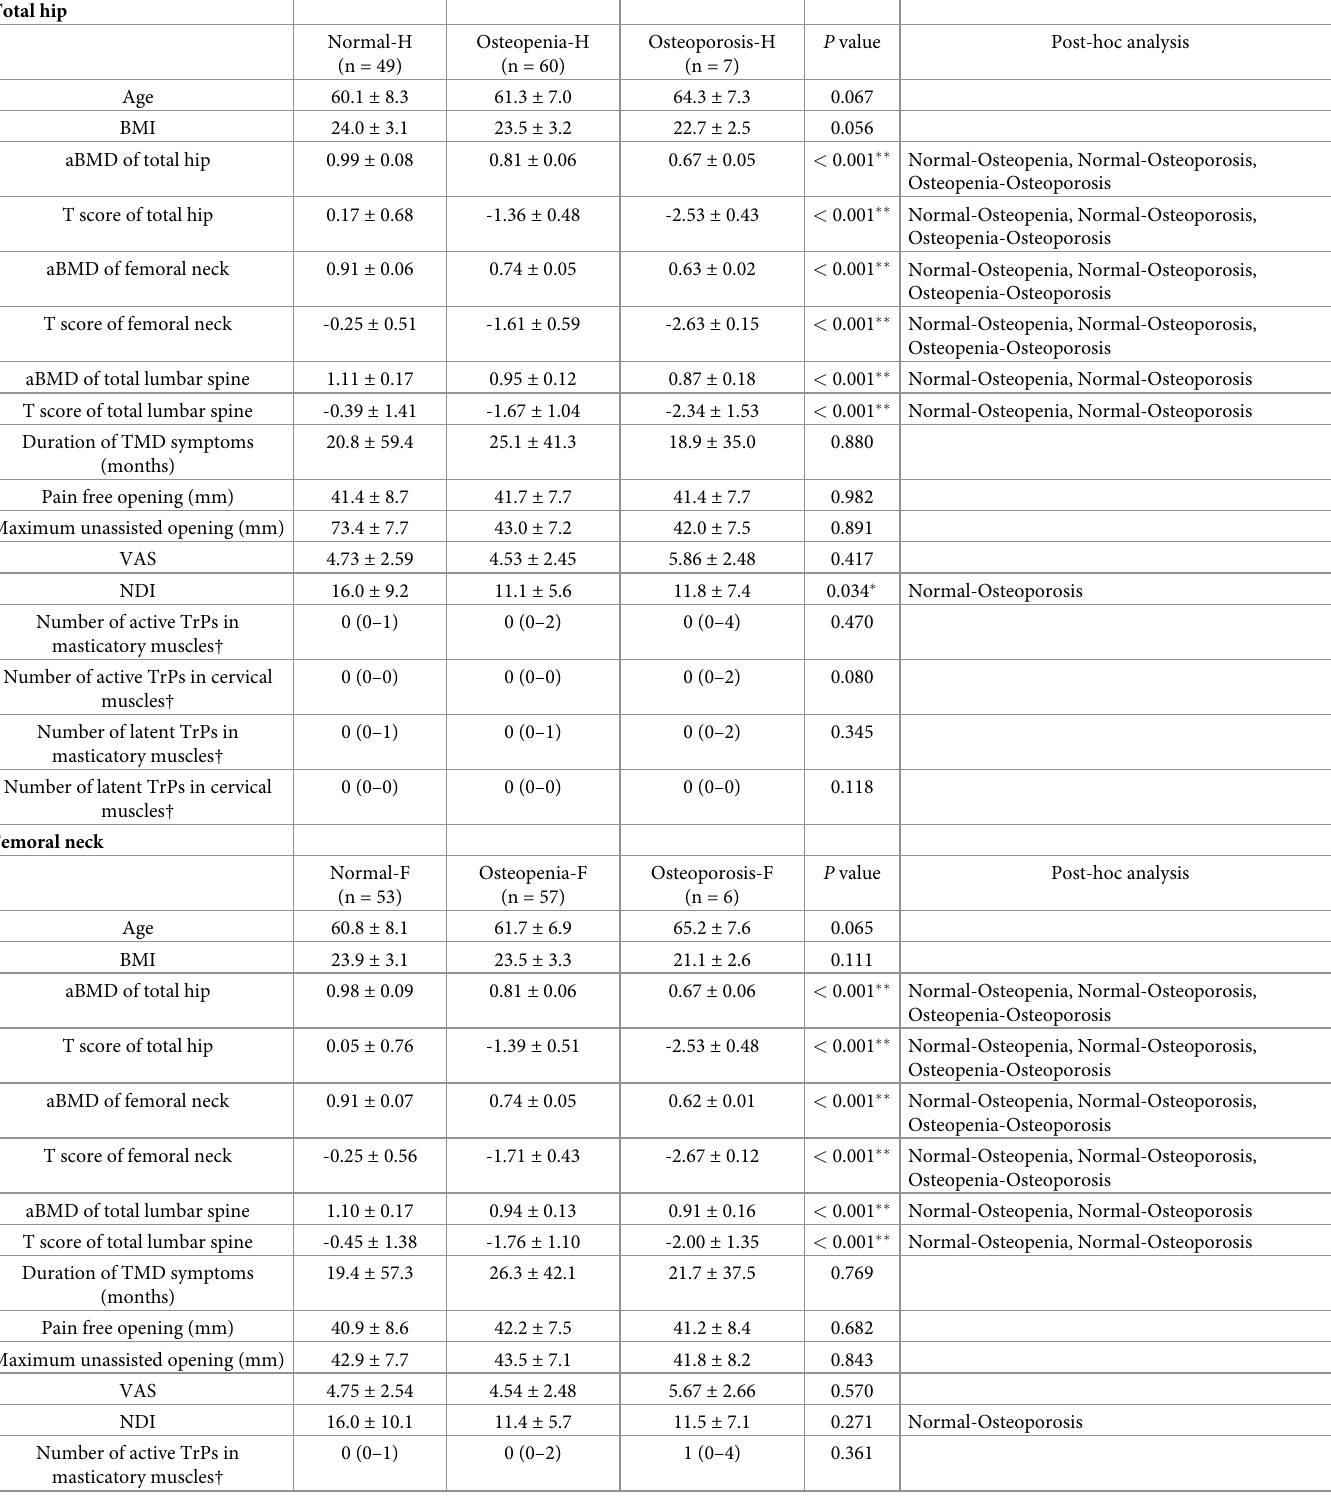
Table 1. Demographic characteristics, bone mineral density, and features of TMD symptoms and neck pain in study